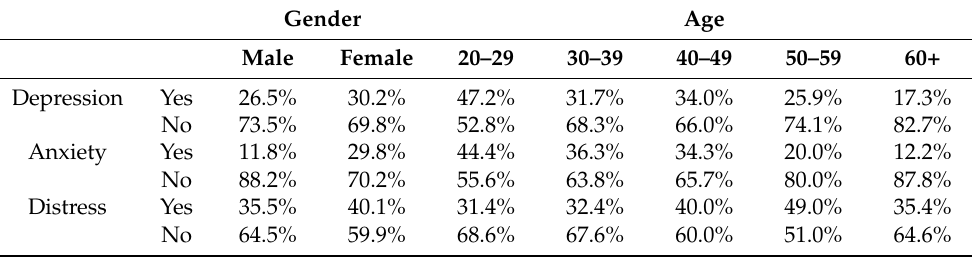
Table 2. Percentage of depression, anxiety, and distress stratified by gender and age.